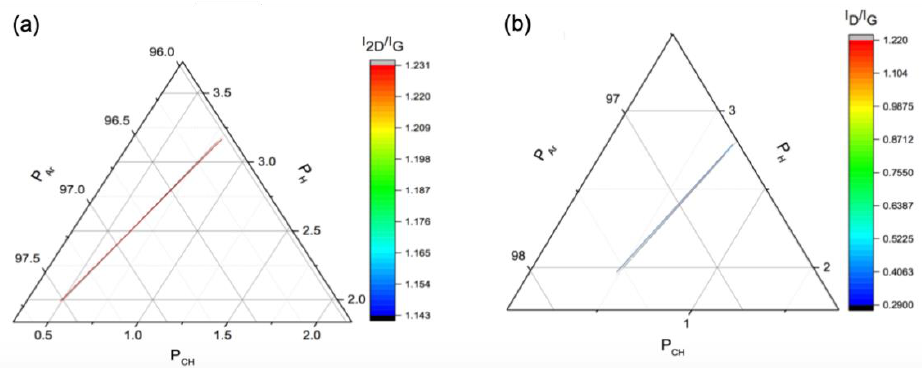
Figure 7. Ternary plots showing Raman intensity ratios as a function of gas partial pressures (P H2 , P Ar and P CH4 ), ( a ) I 2D /I G and ( b ) I D /I G using growth time of 15 min (all axes are normalised with respect to total gas